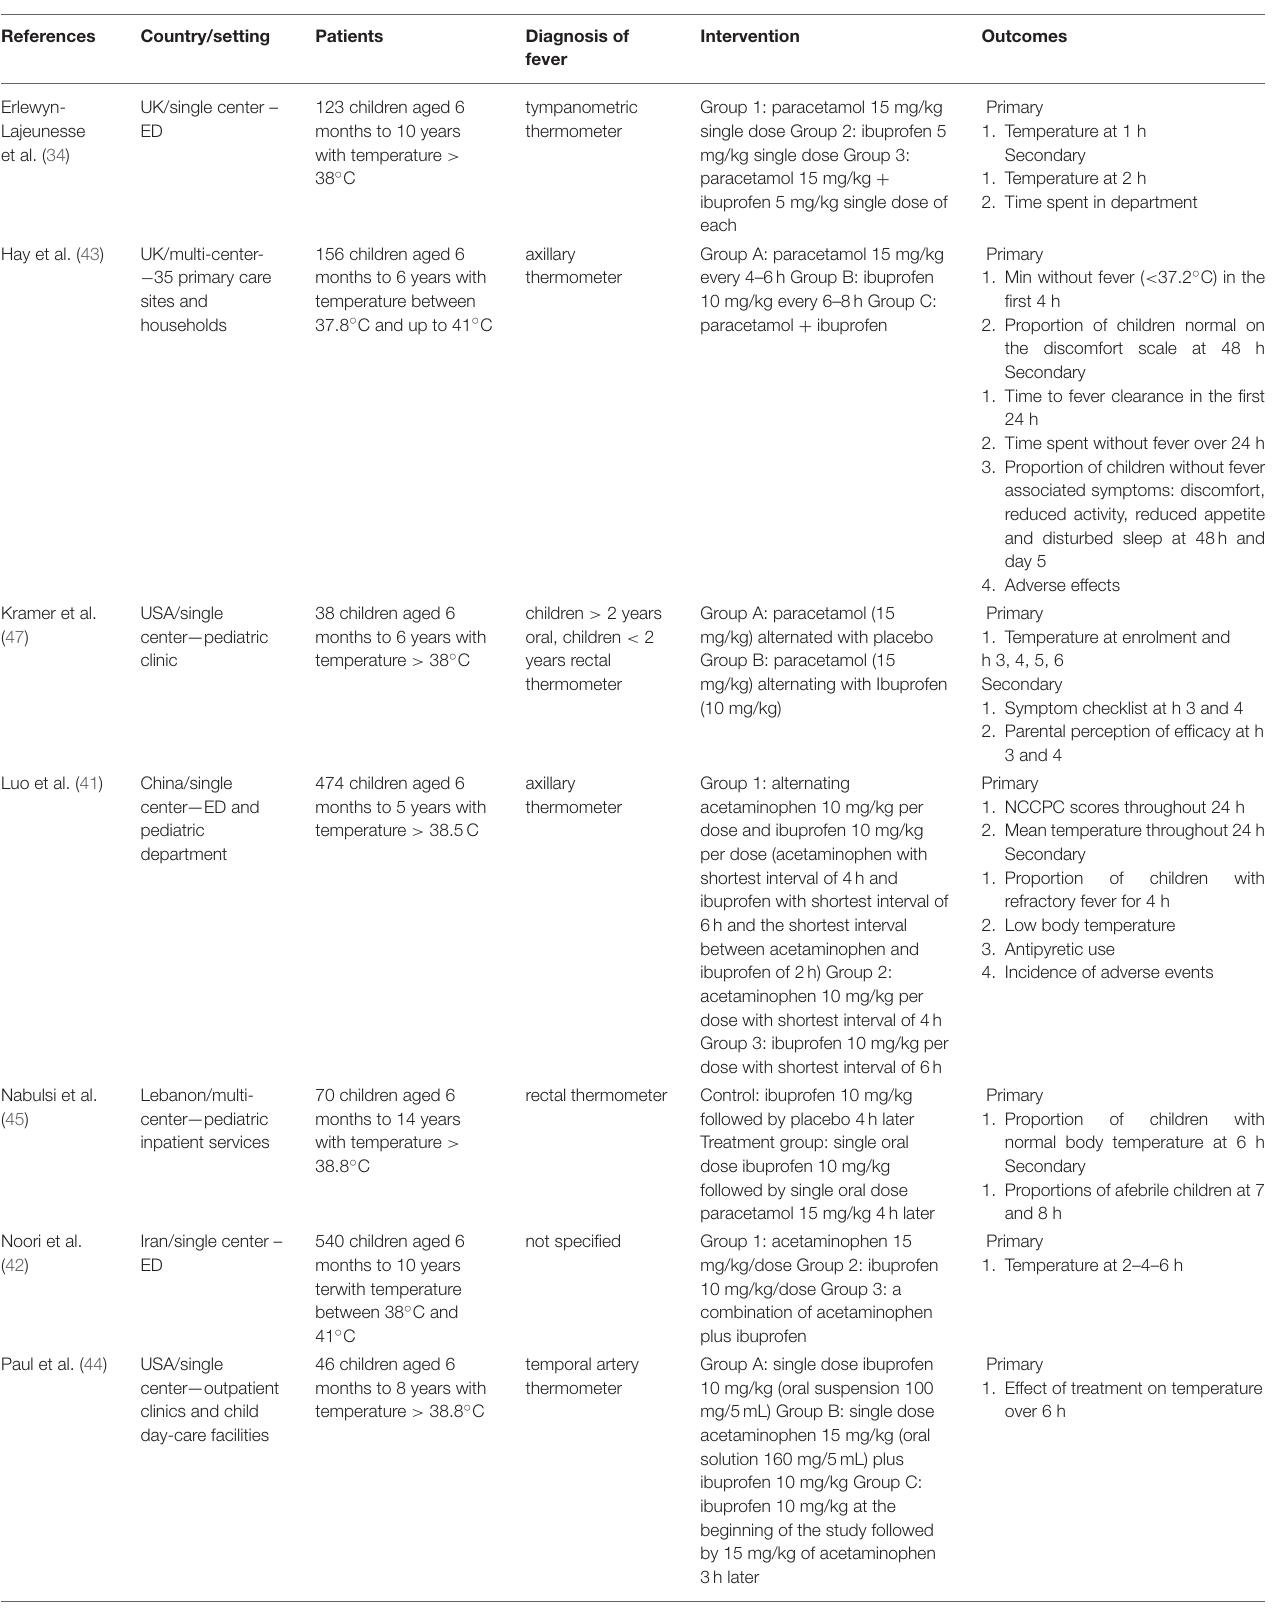
TABLE 2 | Characteristics of the included